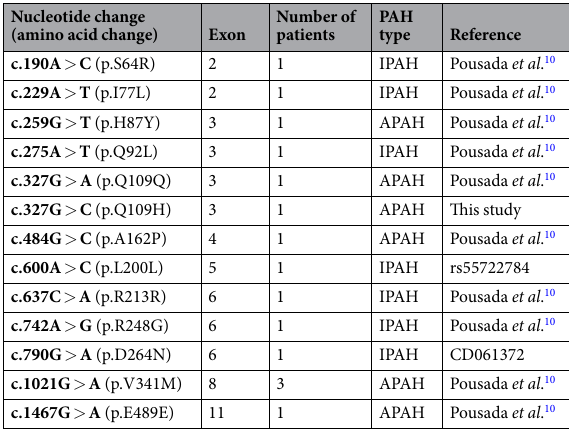
Table 3. Changes with no effect on the mRNA processing.